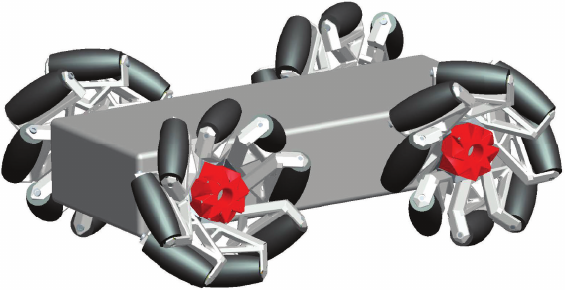
than those along the negative (downward) direction. It is